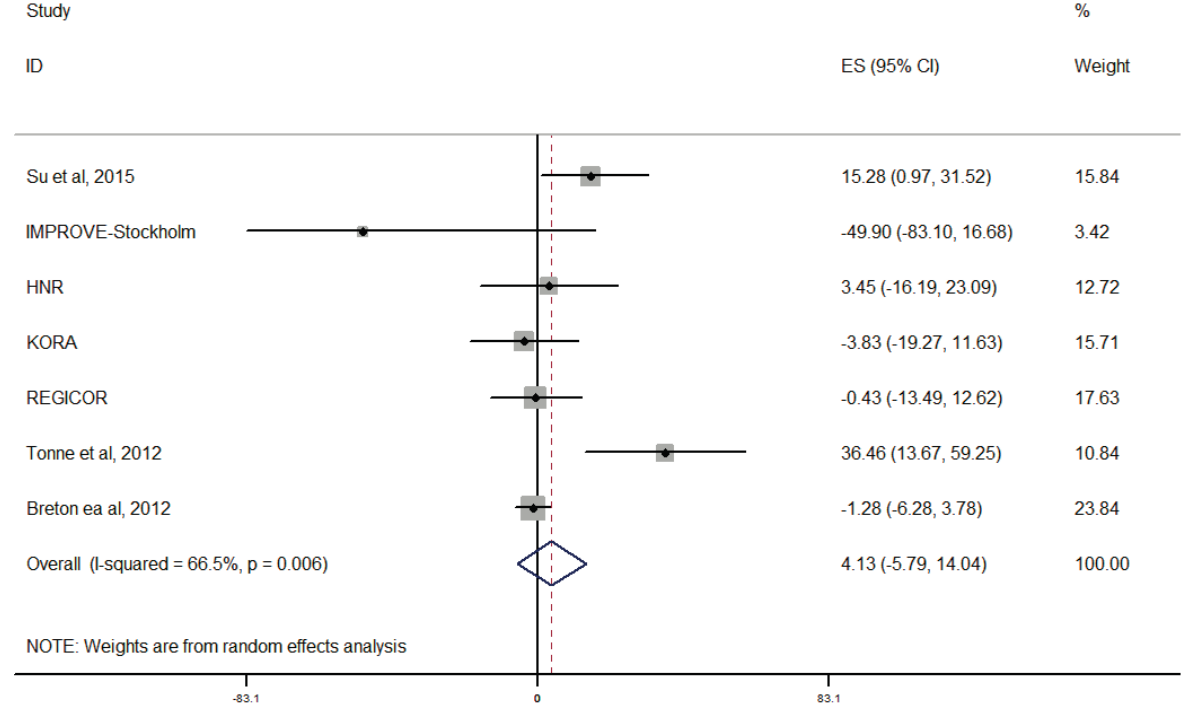
Figure 4. Forest plot for overall analysis of the association between PM 10 and CIMT (random-effects model); * four on-going European cohorts analyzed by Perez et al.